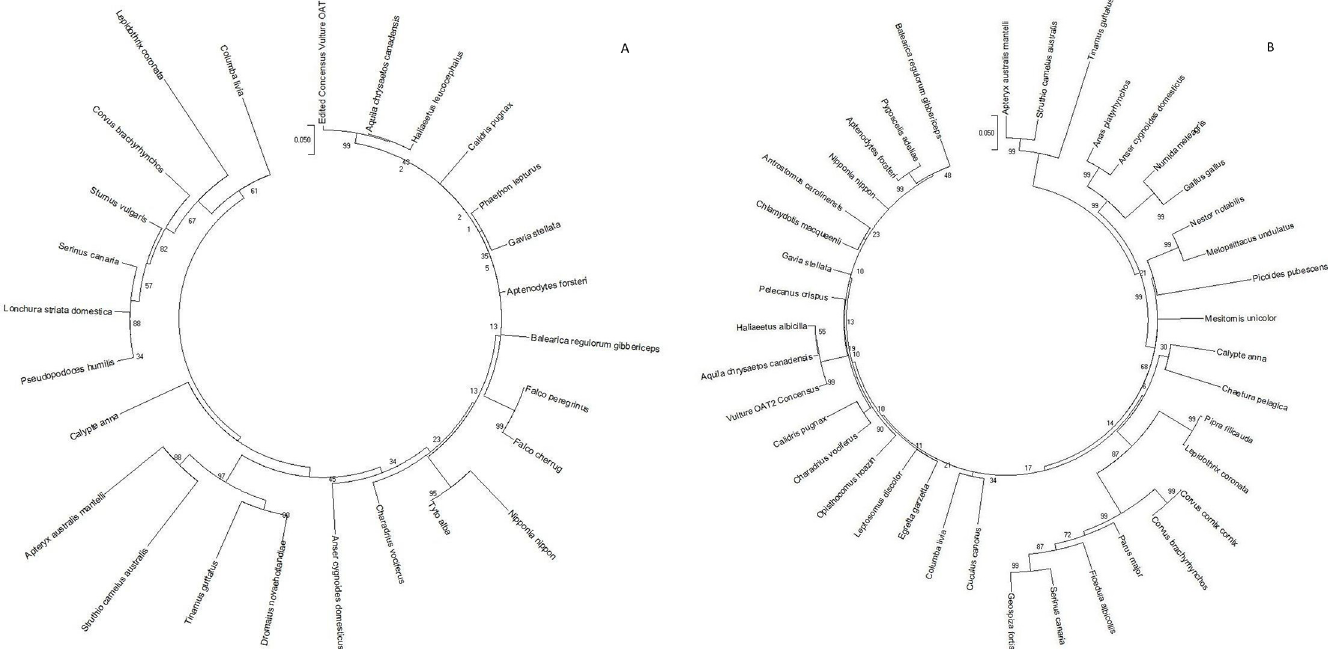
Fig 2. Reconstruction of phylogenetic relationships between (A) OAT1 and (B) OAT2 genes of avian species. A discrete Gamma distribution was used to model evolutionary rate differences among sites (5 categories (+G, parameter = 0.5011 and0.4500)) respectively. https://doi.org/10.1371/journal.pone.0250408.g002 PLOS ONE | https://doi.org/10.1371/journal.pone.0250408 May 4,